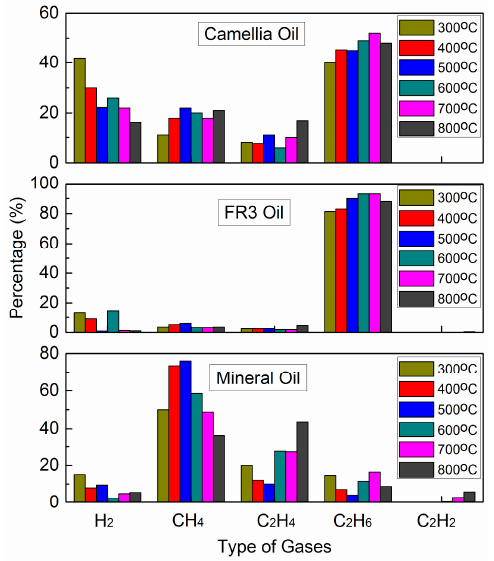
Figure 9. Relative percentages of fault gases in oil as a function of oven temperature (from 300 °C to 800 °C).